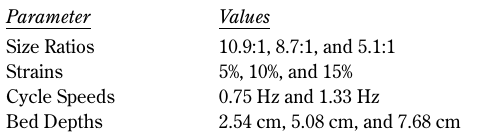
Table 2 Primary testing schedule for binary mixtures of spherical glass beads *